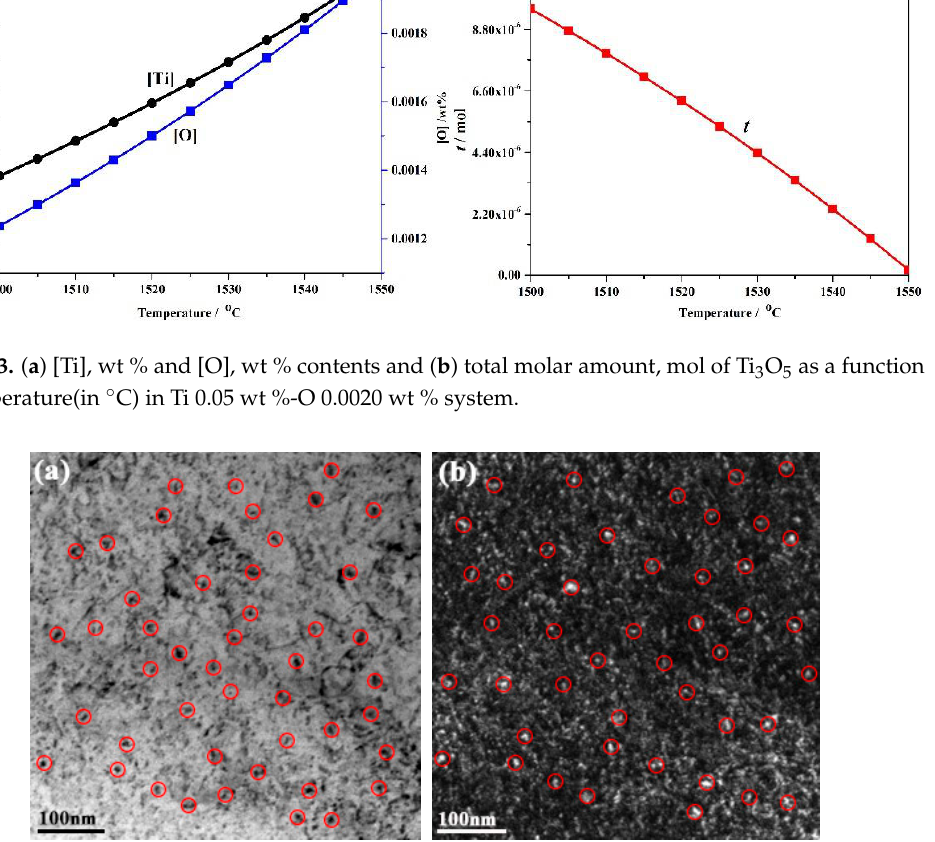
Figure 4. TEM images of the ferrite matrix in the as-cast high-strength steel of Ti 0.05 wt %-O 0.002 wt %: ( a ) Bright field; and ( b ) Dark field.